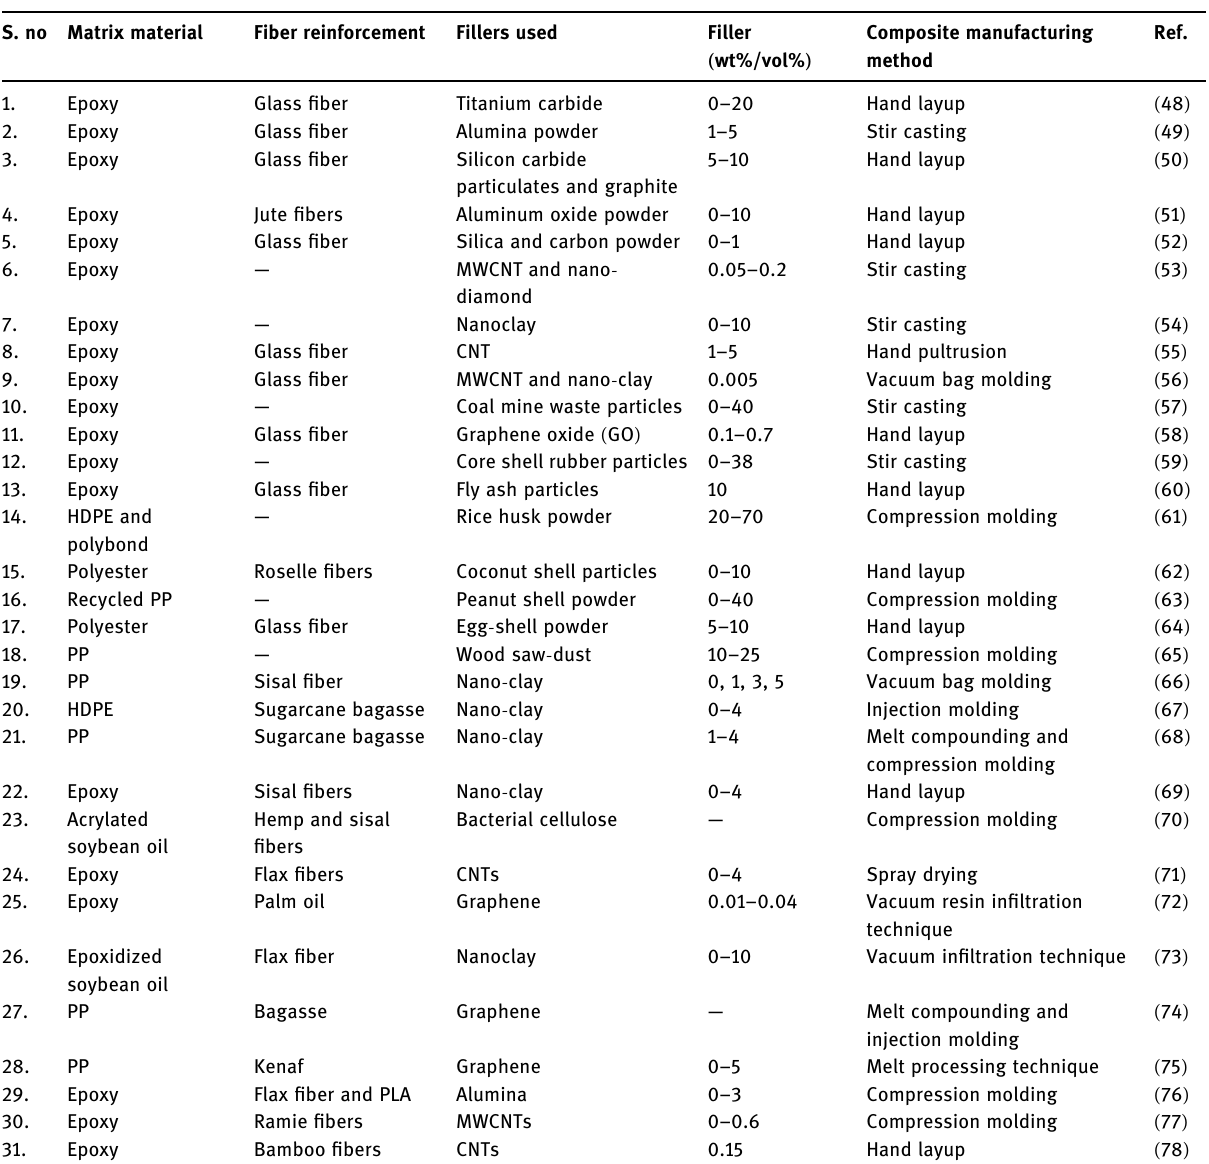
Table 1: Fillers used in polymer